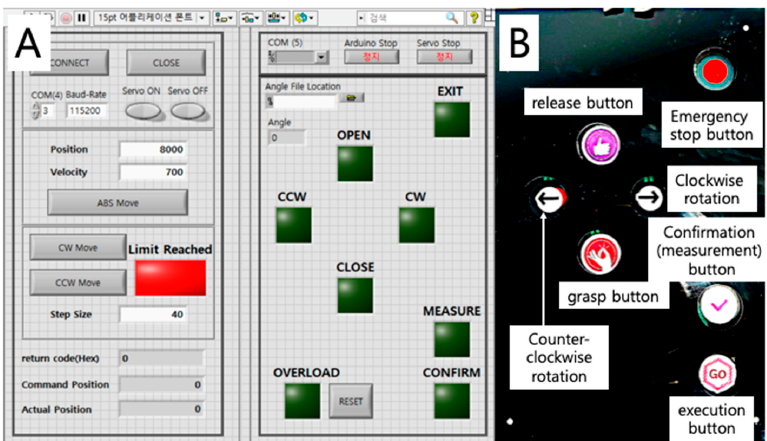
Figure 3. The LabVIEW control panel ( A ) and corresponding hardware control panel with seven buttons ( B ) are shown.